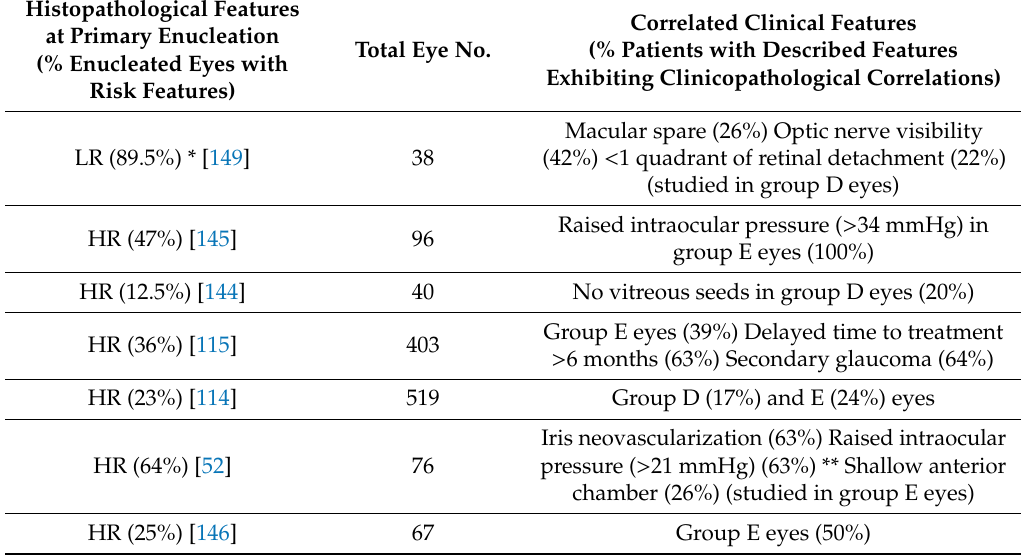
Table 4. Clinicopathological correlations of